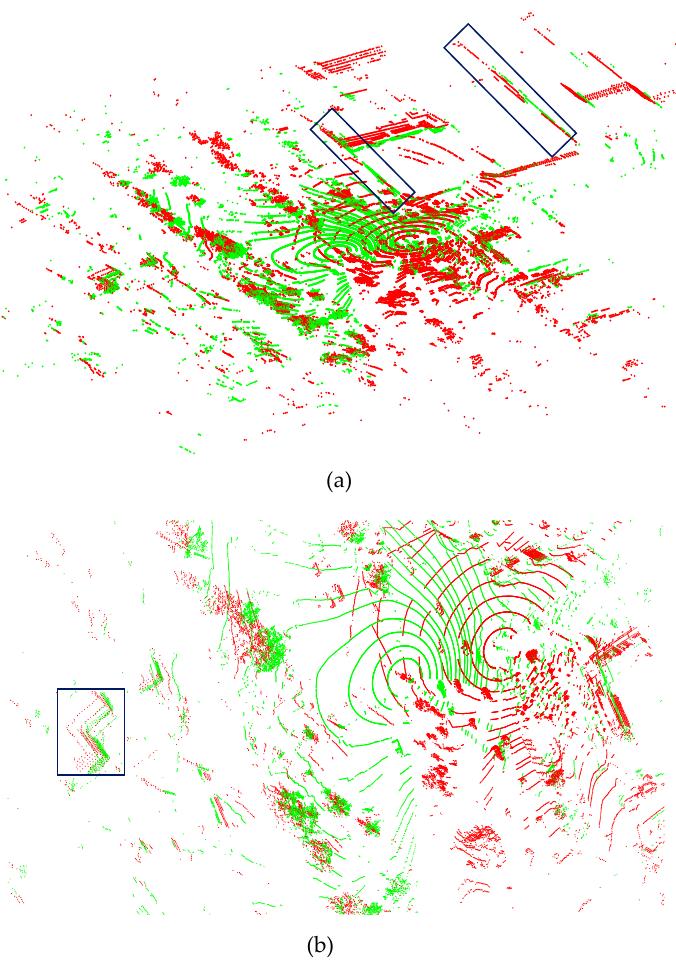
Figure 8. LiDAR data registration with the HC. ( a ) XY Plane. ( b ) Z ‐ axis.